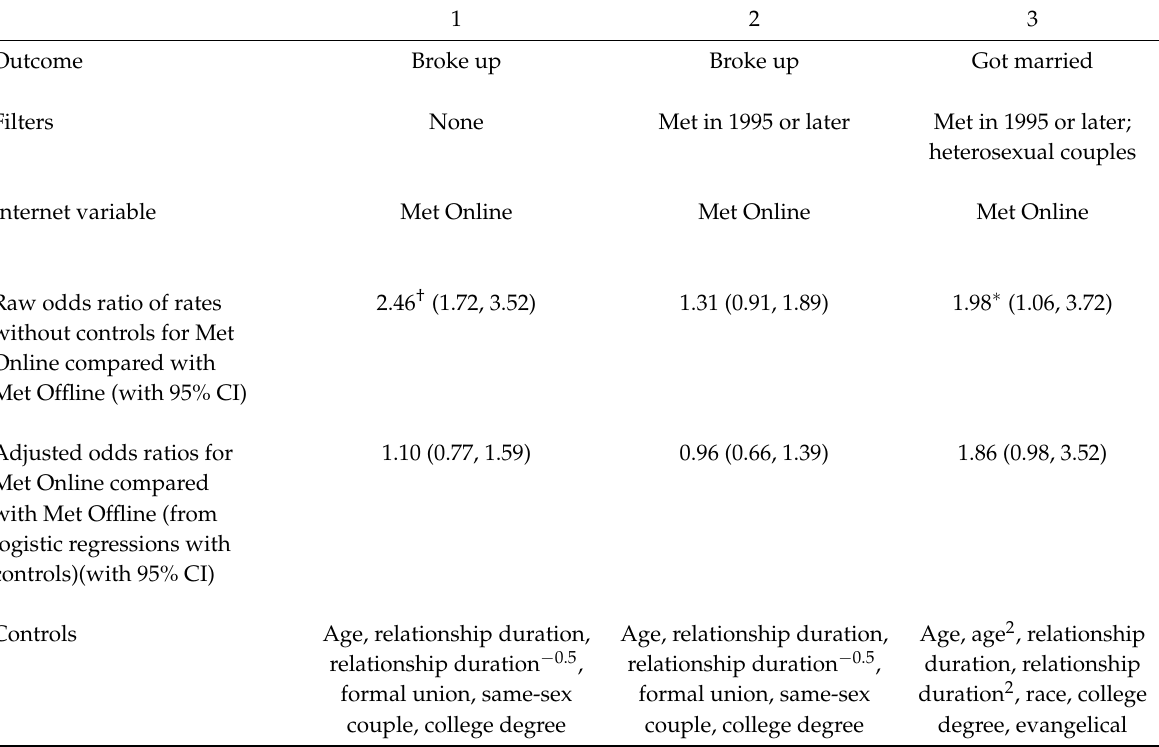
Table 2: Comparison of event history relationship outcomes by Internet influence using prospective data for 2009–2015: odds ratios from weighted event history logistic